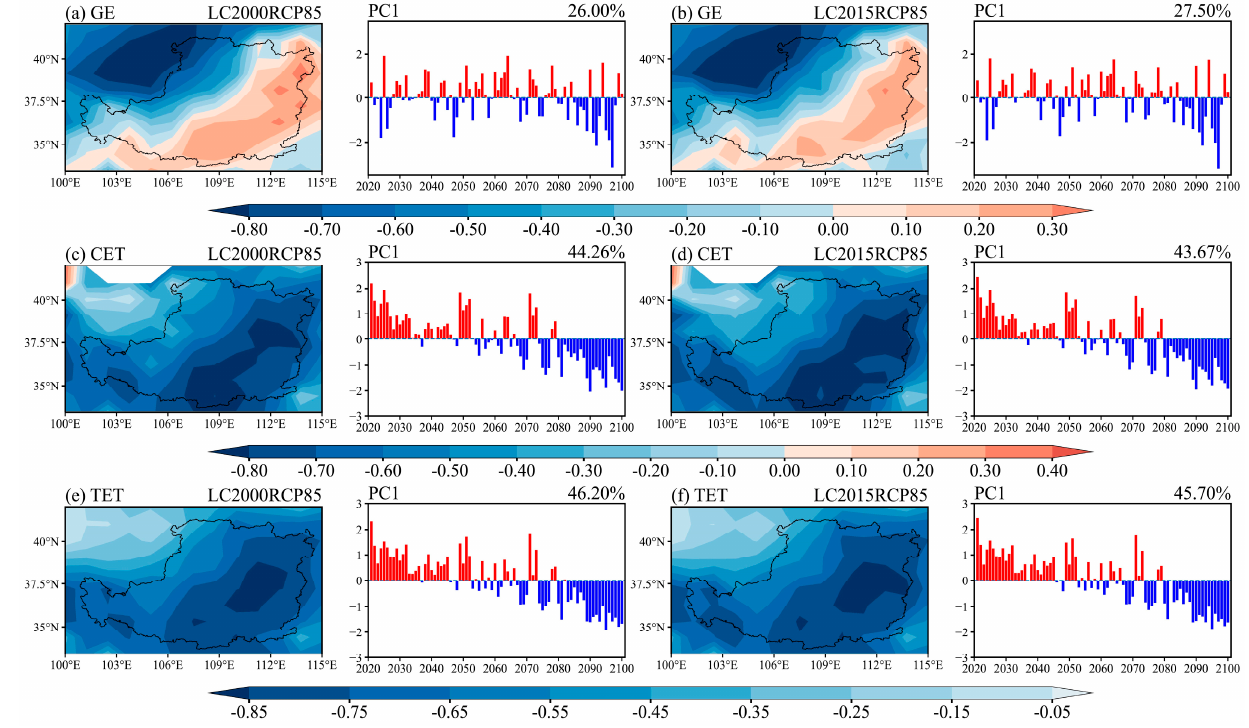
Figure 9. Comparison of spatial patterns and time series of the first EOF modes for responses of ET to different land cover conditions during 2021–2100 in the LP under the RCP8.5 scenario. The left two columns ( a , c , e ) and right two columns ( b , d , f ) show the spatiotemporal patterns of ground evaporation, canopy ET and total ET for the land cover conditions in 2000 and 2015, respectively. Table 1. Quantified contribution of VR to ET in different stages during 2021 − 2100 on the